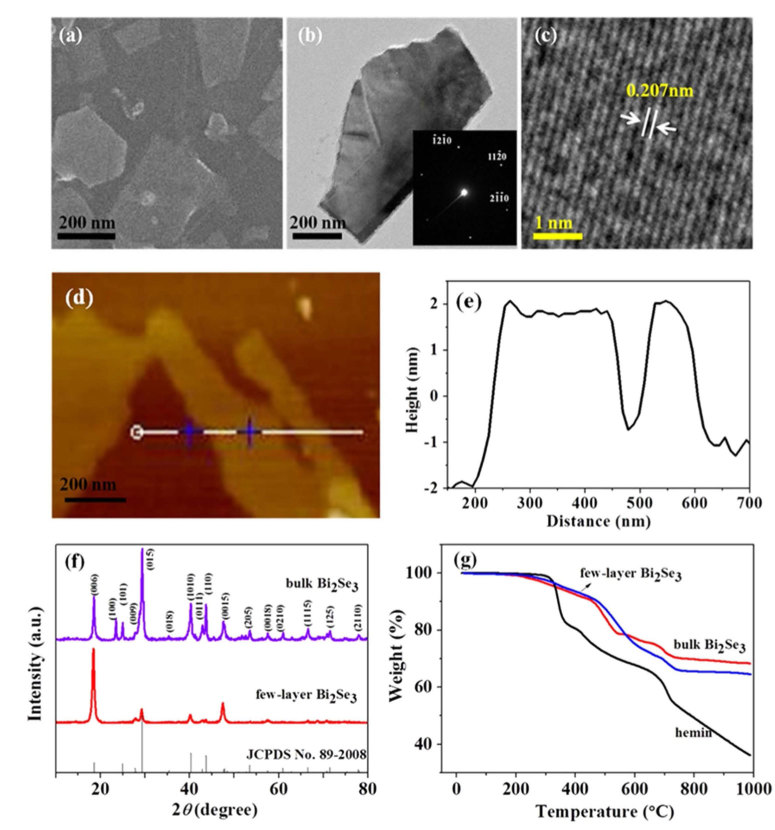
Few-layer Bi2Se3exfoliated with hemin (0.05 mg mL-1) in 0.1% NH3·H2O.(a) SEM image of few-layer Bi2Se3. (b) TEM image of few-layer Bi2Se3, insert: SAED pattern of few-layer Bi2Se3. (c) HRTEM image of few-layer Bi2Se3. (d, e) AFM image and the corresponding height profile of few-layer Bi2Se3. (f) XRD patterns of bulk and few-layer Bi2Se3. (g) TGA curves for hemin, bulk Bi2Se3 and few-layer Bi2Se3 in N2 atmosphere with a ramp of 10°C min-1.